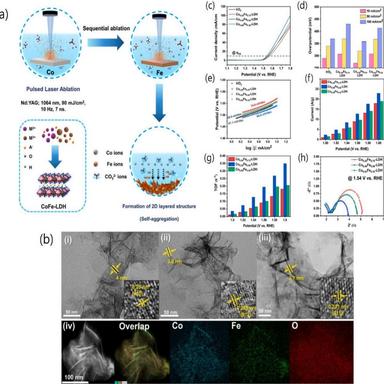
(a) Schematic representation of the synthesis of the CoFe-LDH nanostructure by PLA in an aqueous medium. (b) HR-TEM images of (i) Co0.25Fe0.75-LDH, (ii) Co0.5Fe0.5-LDH, and (iii) Co0.65Fe0.35-LDH nanosheets. (iv) STEM–EDS images showing the distribution of Co, Fe, and O in Co0.5Fe0.5-LDH. (c) OER LSV curves obtained for IrO2, Co0.25Fe0.75-LDH, Co0.5Fe0.5-LDH, and Co0.65Fe0.35-LDH measured at 5 mV/s in a 1.0 M KOH solution. (d) Overpotential of each sample at different current densities. (e) Tafel plots deri